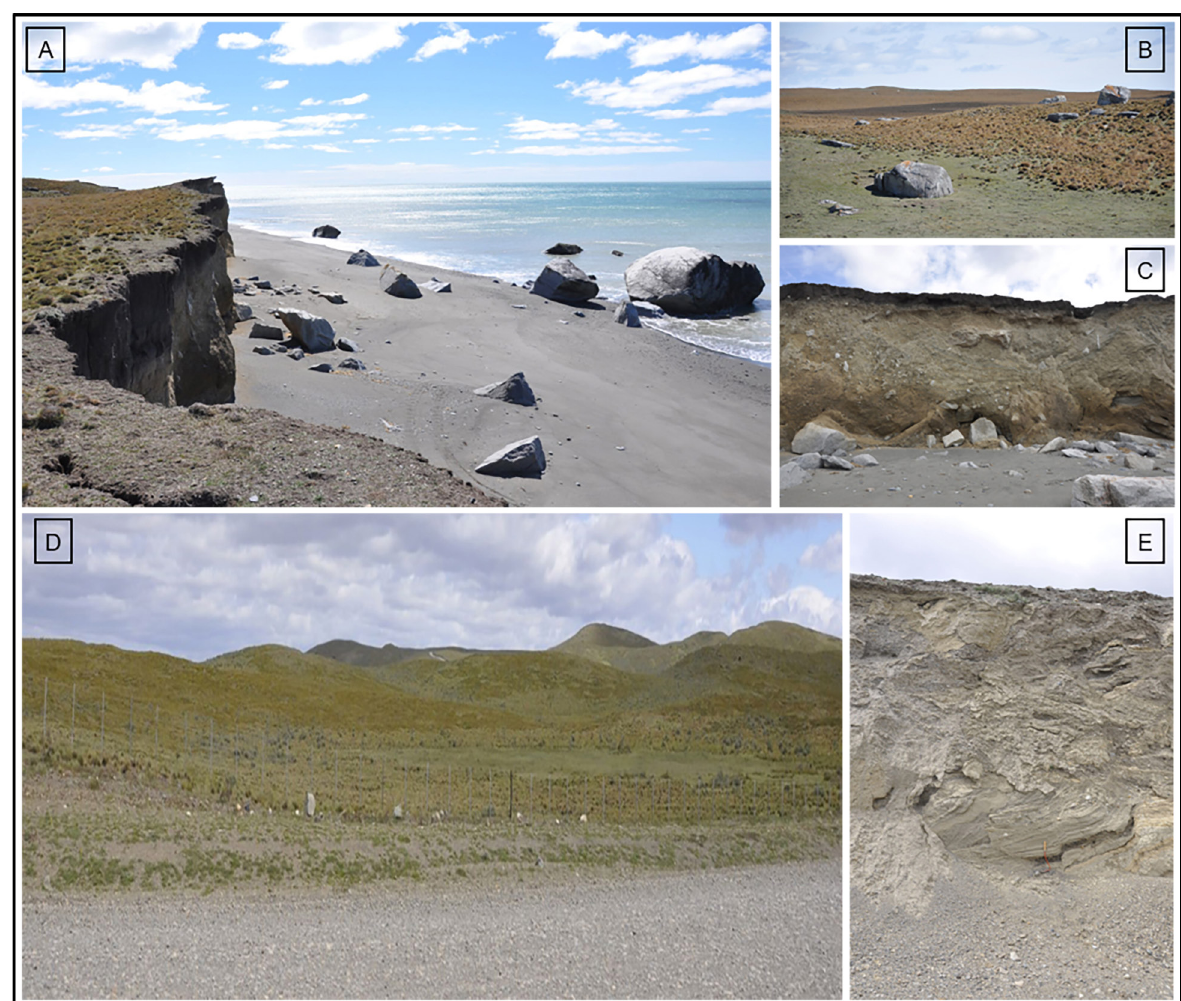
Fig. 5. Punta Sinaí moraine and erratic boulders field. A – the moraine developing a cliff due to wave erosion and boulders scattered in the beach; B – hummocky moraine surface with boulders; C – till exposure eroded by wave-action showing endoglacial boulders; D – San Sebastián moraine: view of the hummocky relief of the lateral moraine complex; E – till exposure showing stratified and deformed